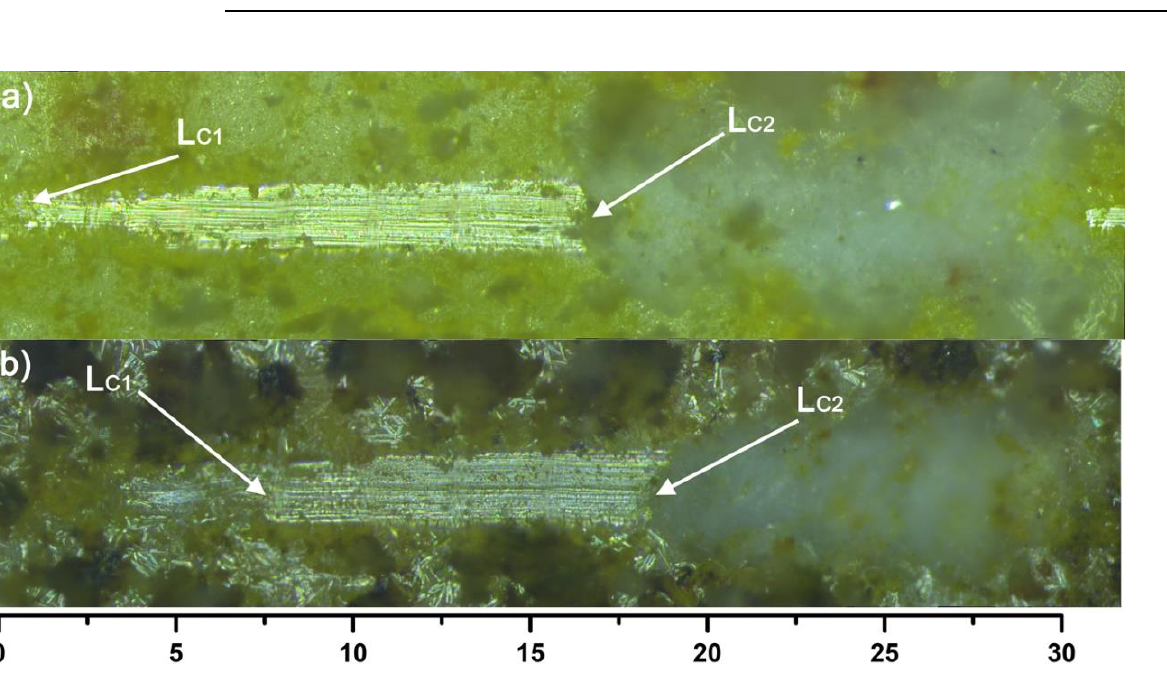
Figure 2. Optical images of the samples (annealed at 650 °C) after the scratch tests. ( a ) BiVO 4 photocatalytic ceramic tiles; ( b ) Ag/BiVO 4 photocatalytic ceramic tiles. Table 2. First critical load ( L C1 ) and second critical load ( L C2 ) of the samples.